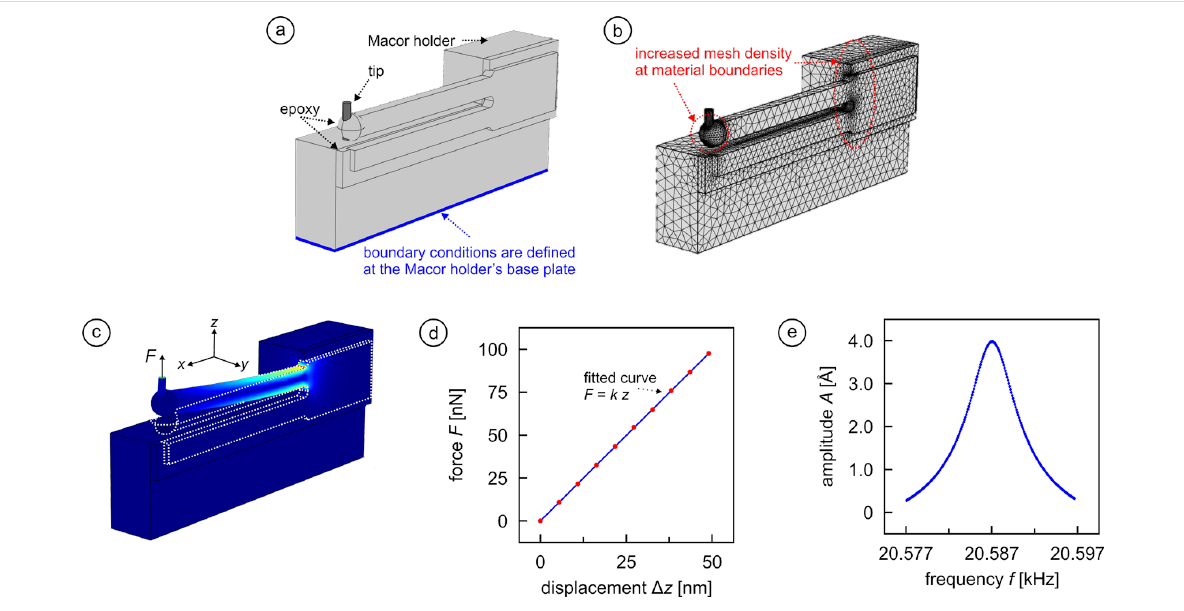
Figure 1: Figure explaining the model and procedures used throughout the paper. (a) Perspective sketch of all parts that were included into the model: tuning fork, Macor holder, epoxy glue and tip. (b) Map of the mesh distribution implemented in the finite element software during the calcula- tions. (c) False color representation of local stress levels for the case where the free prong deforms under the influence of a static force F that is applied to the tip end (see arrow), with brighter colors representing higher stress. (d) Plot of force vs displacement data set from which the spring con- stant k is obtained by curve fitting. (e) Data set obtained from dynamical simulations (i.e., by applying an oscillatory displacement of varying frequen- cy at the holder base plane highlighted in panel a) from which f 0 and Q can be determined.